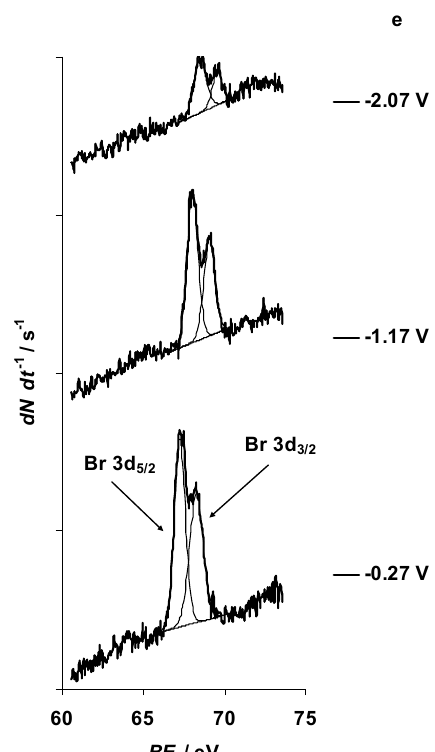
Figure 2. C 1s, N 1s, B 1s, F 1s, and Br 3d X-ray photoelectron (PE) spectra for the 5 wt % EMImBr solution in EMImBF 4 measured at the fixed negative potentials of the C(Mo 2 C) electrode. The binding energy ( BE ) scales for the XPS experiments have been referenced to the BE of the C 1s photoemission line related to aliphatic carbon ( BE = 285.3 eV) measured for the non-polarized and grounded electrode. ( a ) C 1s PE spectra, fitted applying four C 1s photoelectron peak model (regular lines) at various potentials noted in the figure; excitation energy was 400 eV, and the PE signal intensity (d N d t − 1 ) scale between tick marks was 100 counts s − 1 . ( b ) N 1s PE spectra; excitation energy was 500 eV, and the PE signal intensity scale between tick marks was 35 counts s − 1 . ( c ) B 1s PE spectra; excitation energy was 250 eV, and the PE signal intensity scale between tick marks was 20 counts s − 1 . ( d ) F 1s PE spectra; excitation energy was 800 eV, and the PE signal intensity scale between tick marks was 8 counts s − 1 . ( e ) Br 3d PE spectra; excitation energy was 120 eV, and the PE signal intensity scale between tick marks was 20 counts s − 1 .